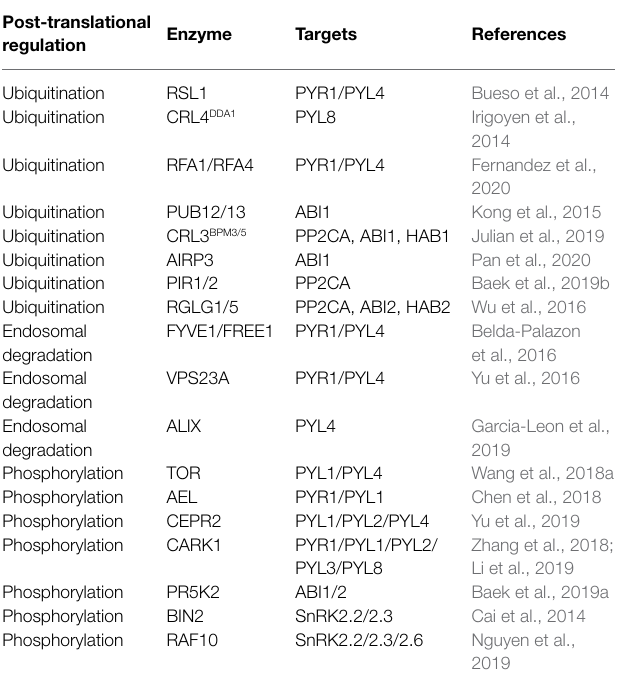
TABLE 1 | Post-translational regulation factors of ABA core components in Arabidopsis